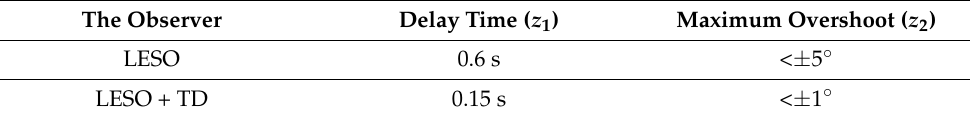
Table 4. The results of the observation.